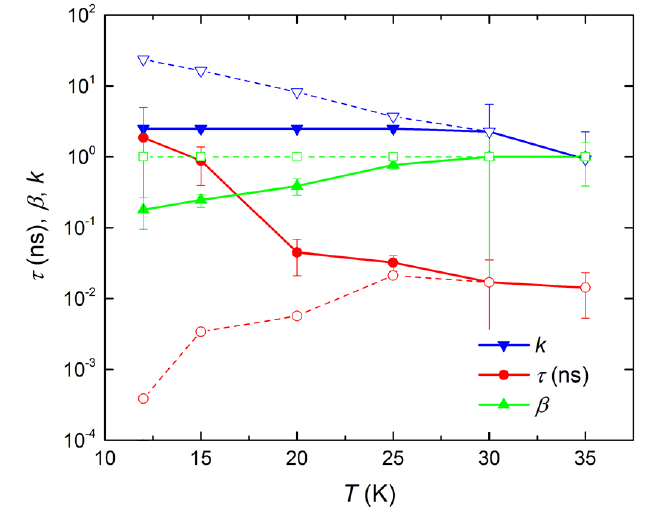
Figure 4. Parameters τ , β and k analysed by a fit of the Weron function to the intermediate scattering functions observed for different temperatures by neutron (resonance) spin echo spectroscopy (N(R)SE) measurements with no restrictions except 0 ≤ β ≤ 1 (dashed lines and open symbols) and with restrictions (i) 0 ≤ β ≤ 1, (ii) τ constantly increasing with decreasing T and (iii) k = 2.5 for T ≤ 25K (solid lines and closed symbols). The error bars for the non-restricted fits (not shown) are very large because the parameters are strongly